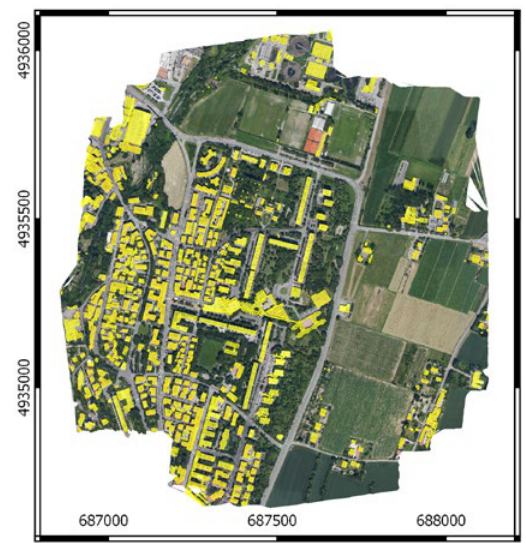
Figure 3. The true orthophoto (by ContextCapture)